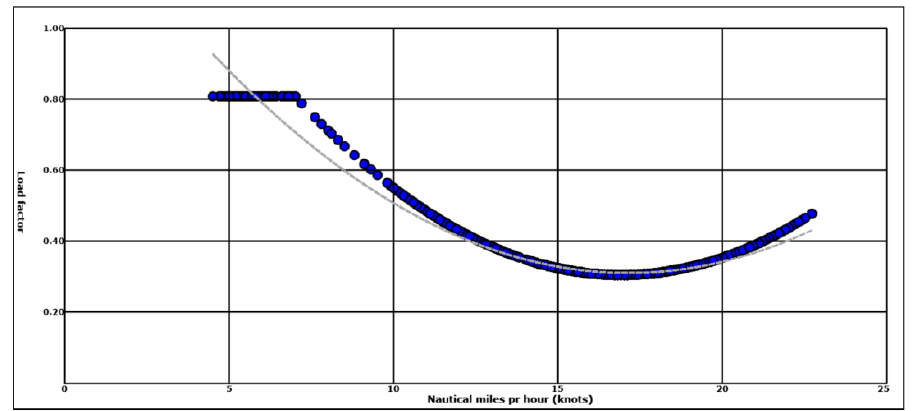
Figure 11. Load factor (actual power over installed power) profile for Norwegian Star , May 2016, using Finnmarken data. Blue points are estimated load factors for different speed values, gray line is fitted second-degree polynomial trend-line.